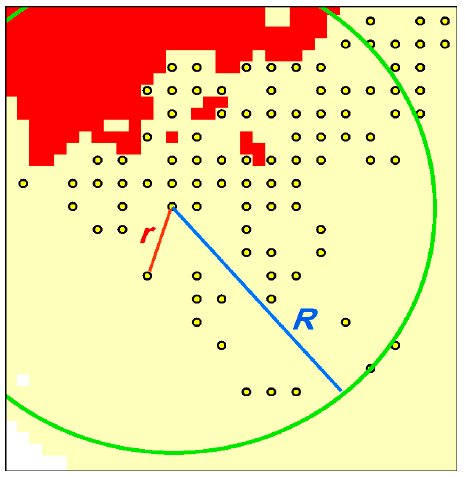
Figure 11. Schematic illustration of how the kernel density function works.